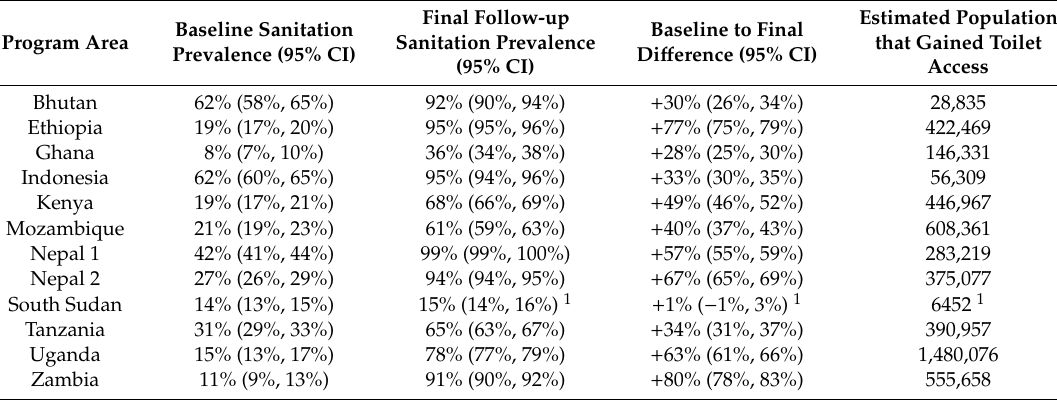
Table 2. Change in coverage of basic sanitation, shown by program